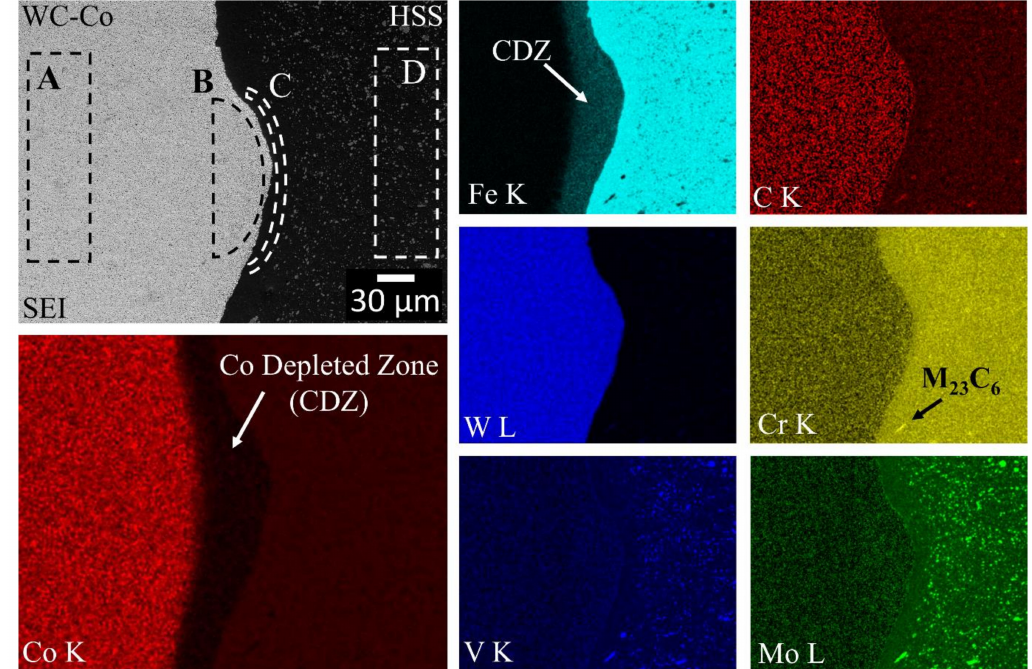
Figure 14. EDS chemical (at%) maps of the HSS / WC-Co interface (region W1 in Figure 2). Scan size of 355 × 281 µ m. The dashed rectangles in the SEI image indicate the areas selected for a semi-quantitative EDS analysis, the results of which are listed in Table 2 and shown in Figure 16. The white arrow in the Co map indicates that the transitional layer corresponds to a Co depleted zone (CDZ), which is rich in Fe. The black arrow in the Cr map indicates an M 23 C 6 Cr-based